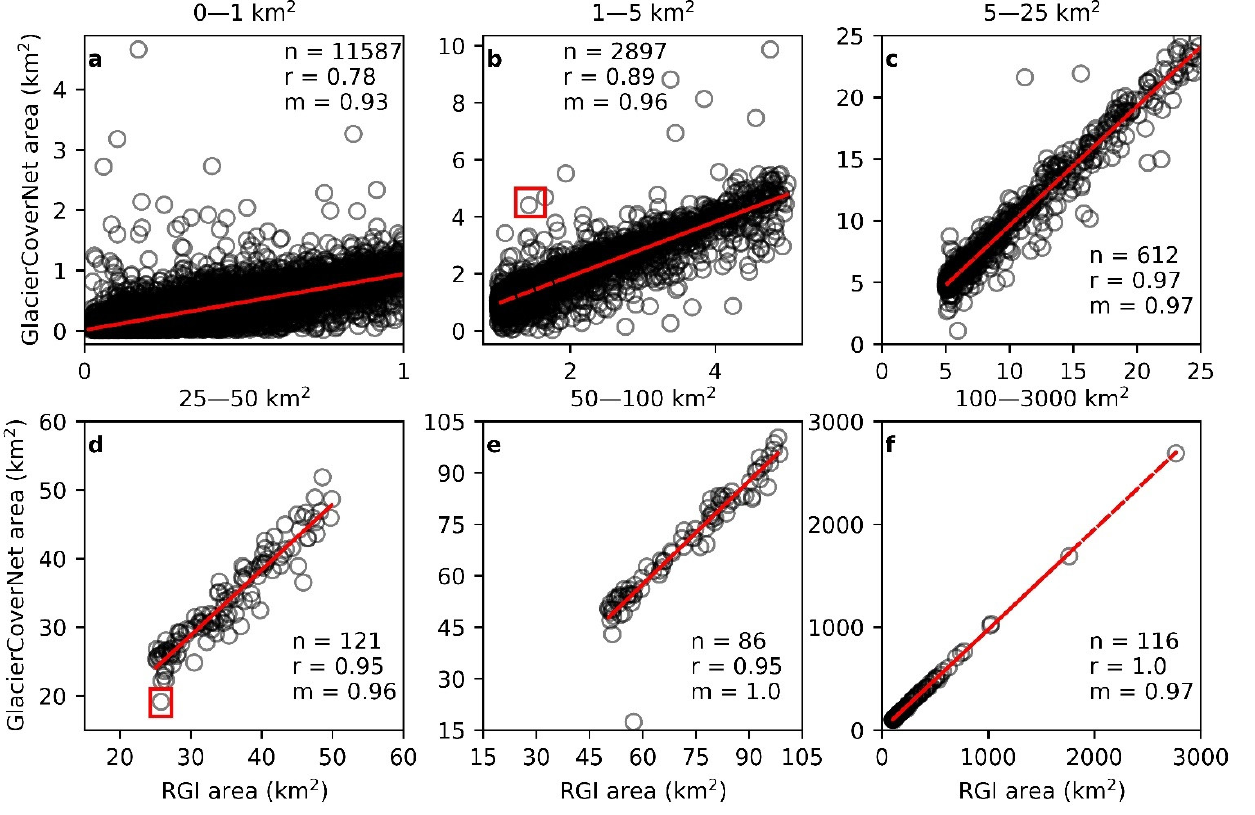
Figure 6. Comparison of glacier sizes from RGI 6.0 and the GlacierCoverNet model outputs with Pearson’s r values and the slope (m) of the linear regression line (shown in red) for ( a ) glaciers from 0 to 1 km 2 , ( b ) glaciers from 1 to 5 km 2 , ( c ) glaciers from 5 to 25 km 2 , ( d ) glaciers from 25 to 50 km 2 , ( e ) glaciers from 50 to 100 km 2 , and ( f ) glaciers from 100 to 3000 km 2 .Highlighted glaciers (red box) in subplots b and d are included in Section 4.2 Figure 7 (right and left, respectively). Note that axes scales in plots a and b are intentionally different to accommodate the full range of variability in capture of smaller